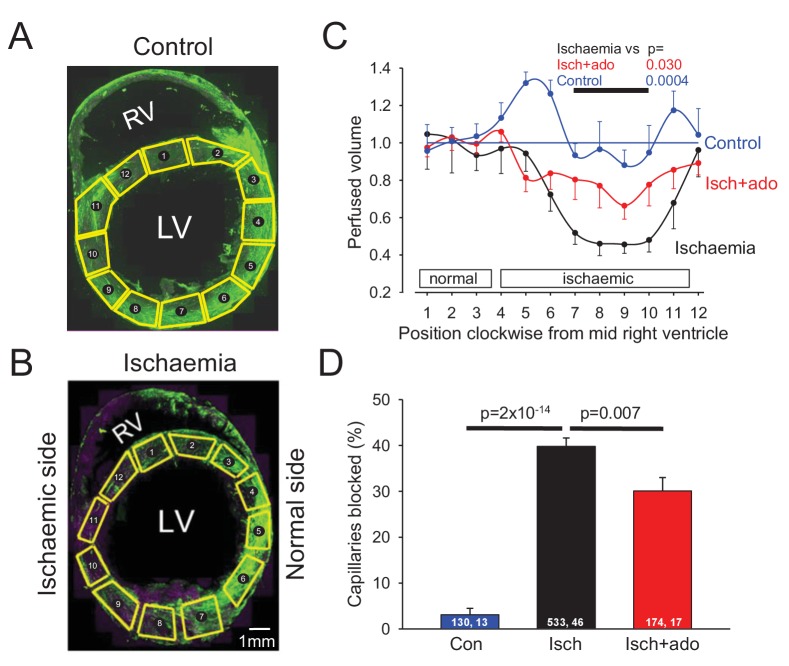
Ischaemia and reperfusion lead to no-reflow mediated by capillary block.(A, B) Low power view of sham-operated heart (A) and a heart after LAD coronary artery occlusion and reperfusion (B), with perfusion volume assessed as intensity of FITC-albumin (green). In (B) vessels are also labelled with isolectin B4 - Alexa Fluor 647 (purple) to define location of unperfused tissue. Regions of interest (ROIs) for analysing the intensity of FITC-albumin fluorescence are shown in yellow. (C) Perfused volume (assessed from mean FITC-albumin intensity), in ROIs indexed with numbers starting at the interventricular septum and proceeding clockwise around the left ventricle (as seen from above), for five sham-operated hearts (control), six hearts made ischaemic and reperfused (ischaemia), and eight hearts made ischaemic and exposed to adenosine starting 5 min before reperfusion (isch + ado). (D) Percentage of capillaries blocked in the anterior wall of the left ventricle for the three experimental conditions (numbers on bars are of ‘capillaries examined, image stacks examined’). Data are mean ± s.e.m. P values are corrected for multiple comparisons.